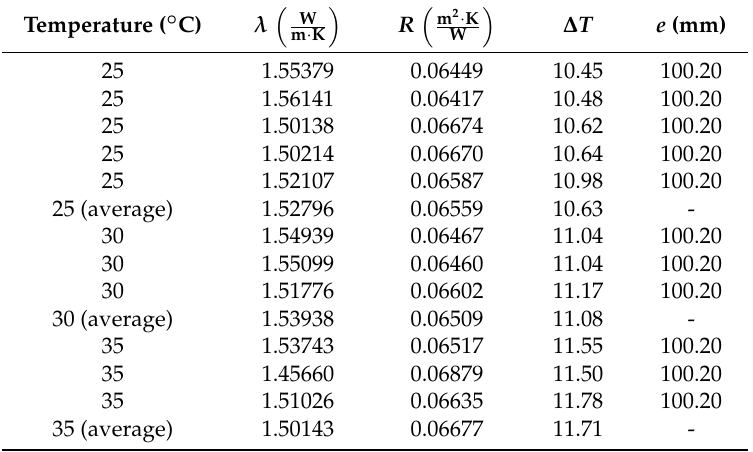
Table A3. Experimental data obtained for thermal conductivity determination